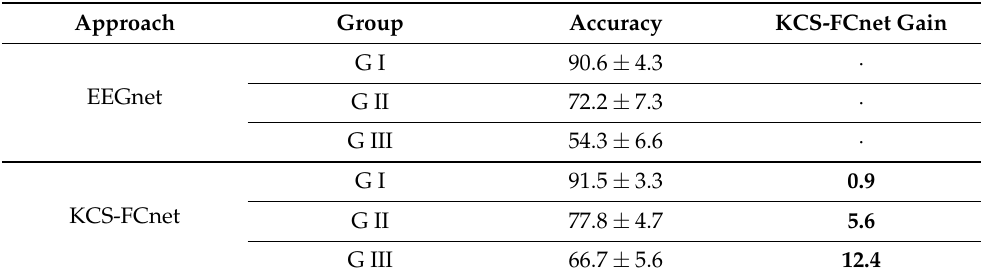
Table 2. Group-based accuracy results for EEGnet and KCS-FCnet. The average accuracy for the best, medium, and worst-grouped subjects is depicted. The KCS-FCnet average increase for each cluster is also reported.